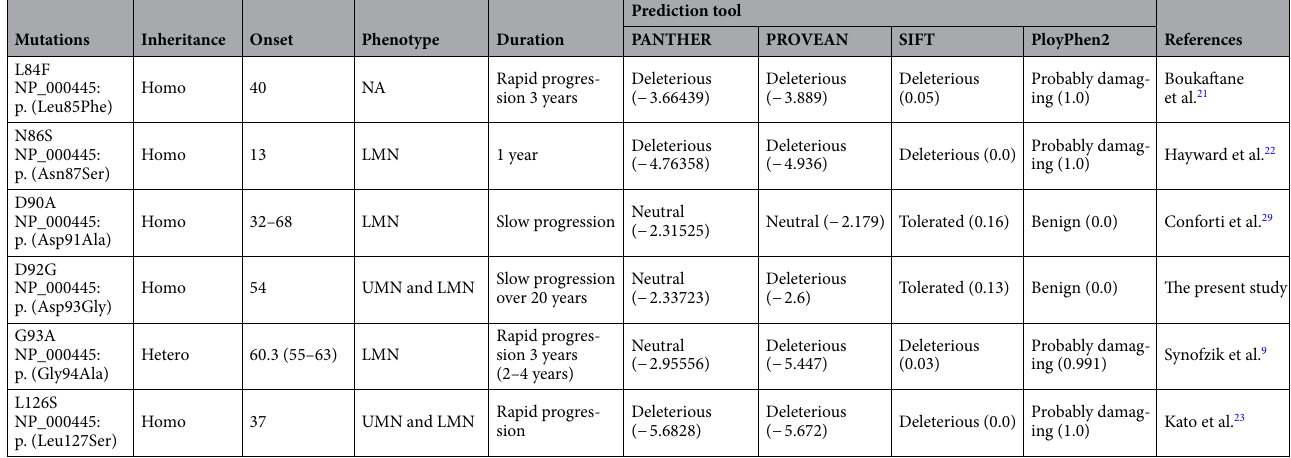
Table 1. In silico analysis of FALS